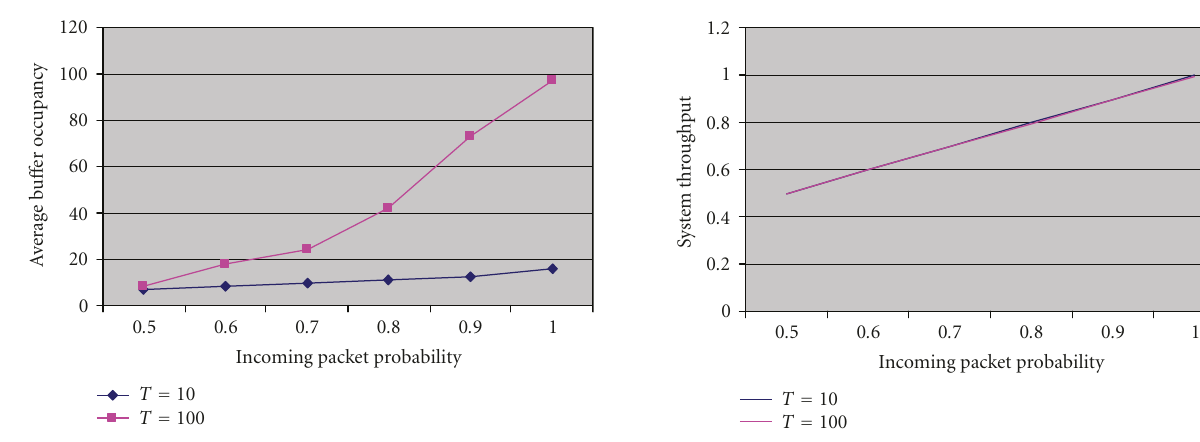
Figure 17: System throughput versus incoming packet probability ( T = 10,100).